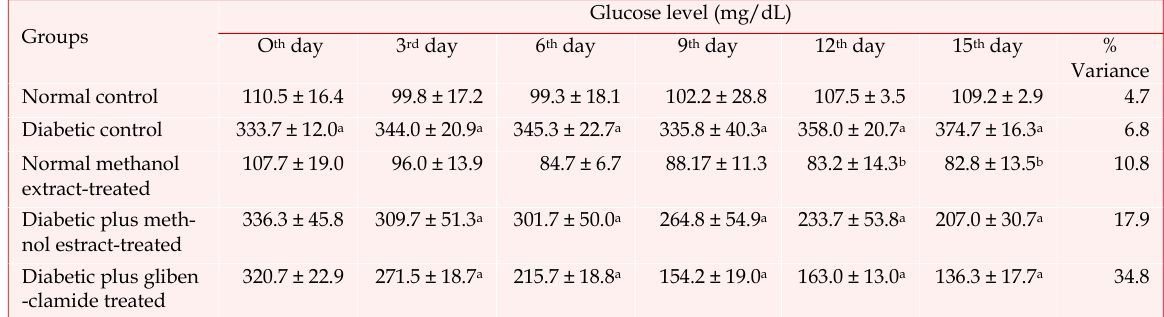
Effect of Gaultheria trichophylla extract on blood glucose level in diabetic mice